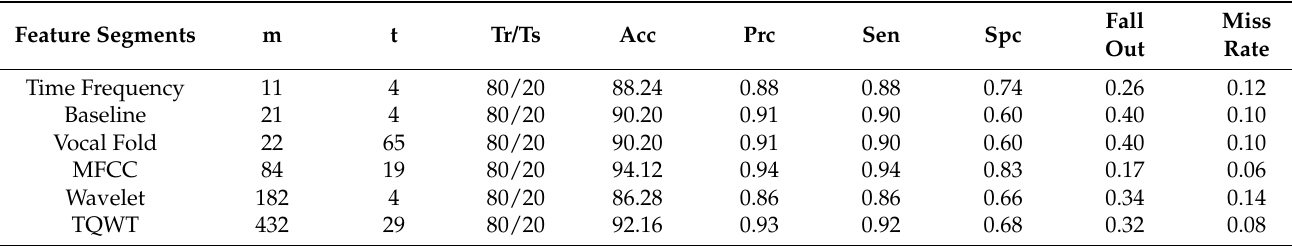
Table 6. Maximum performance received for Random Forest classifier with minimum number of decision trees on primary and derived features of Istanbul acoustic dataset.